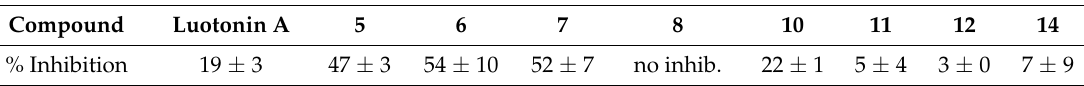
Table 1. In vitro cell growth inhibition (%) of compounds 5 – 8 , 10 – 12 and 14 towards SW480 cancer cells at a fixed concentration of 40 µ M (MTT viability assay